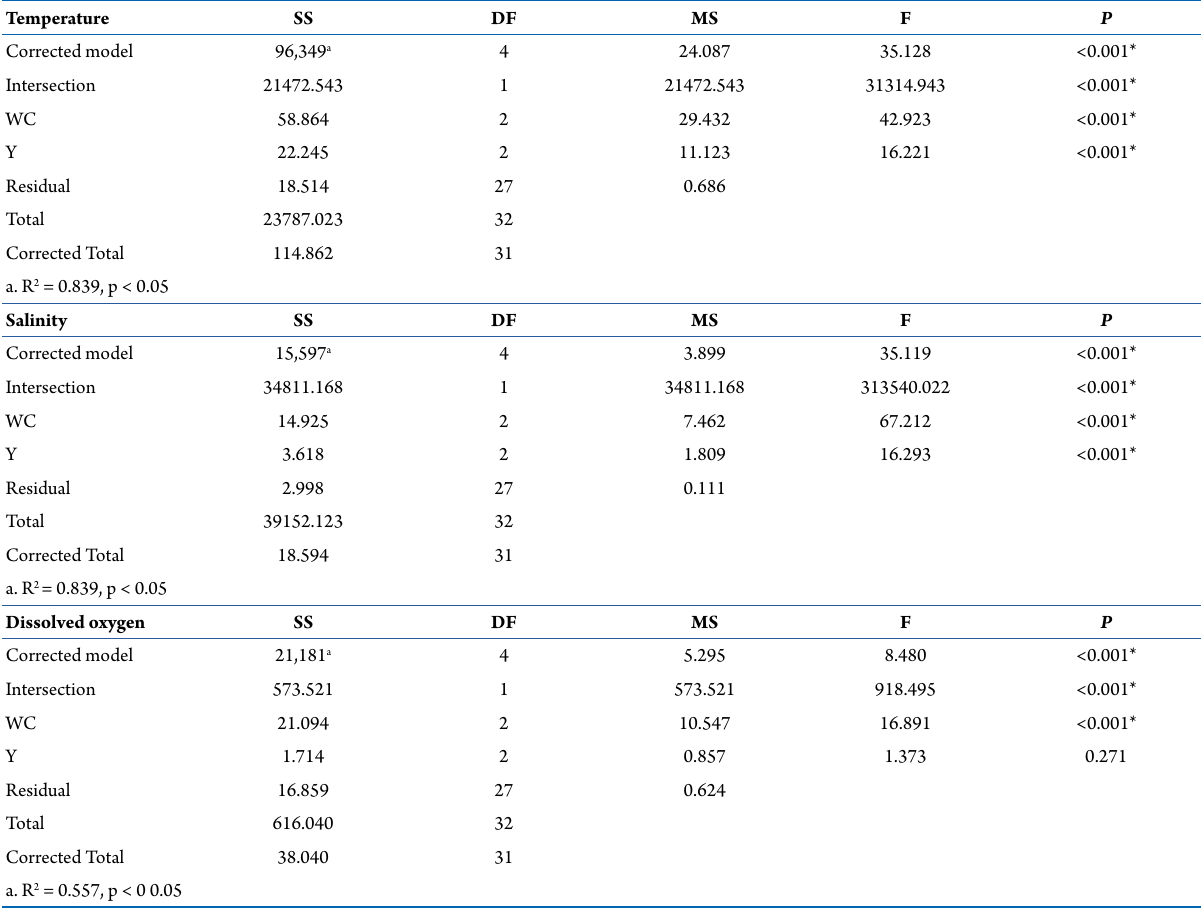
Table 2. The model Generalized Least Squares was applied to compare the temperature (°C), salinity and dissolved oxygen (mgl -1 ) from zones (Z) of sampling, under weather conditions (Wc) for each sampling year (Y). *, significant differences Temperature SS